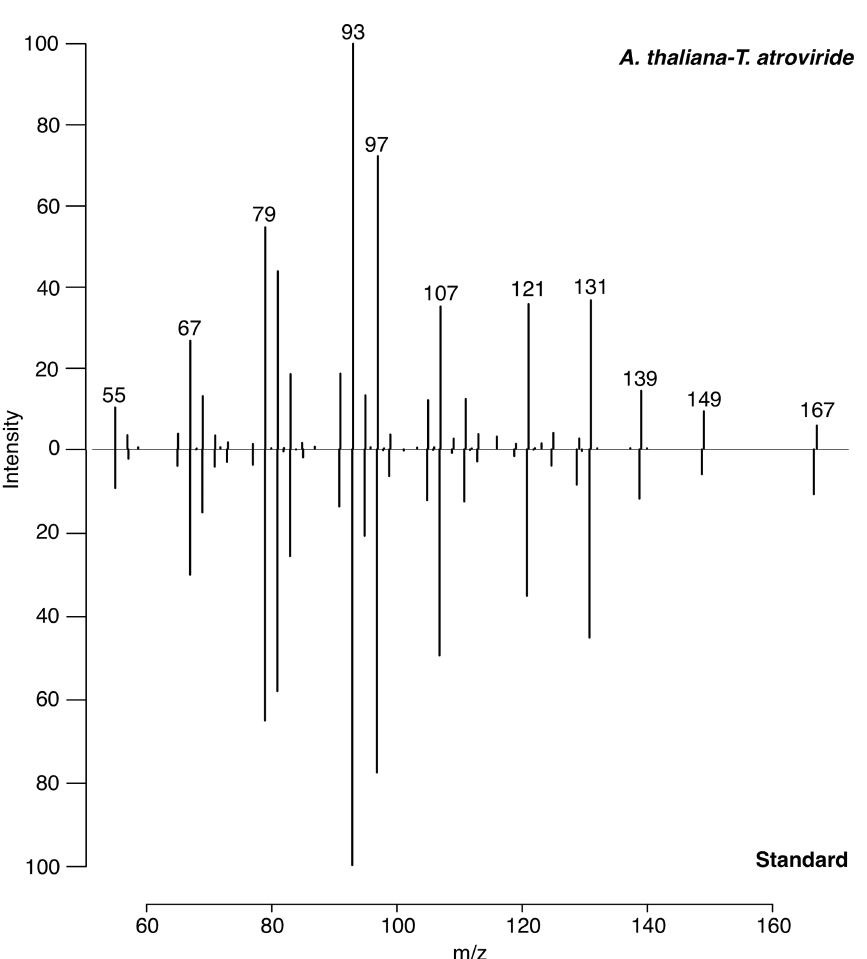
Figure 2. Fragmentation of 6-PP, measured by low-temperature plasma (LTP) ionization mass spectrometry (MS), on an ion trap with 30 eV collision energy. The spectra from the plant-fungal interaction (top) and a genuine 6-PP standard (bottom) demonstrate high agreement, confirming the identity of